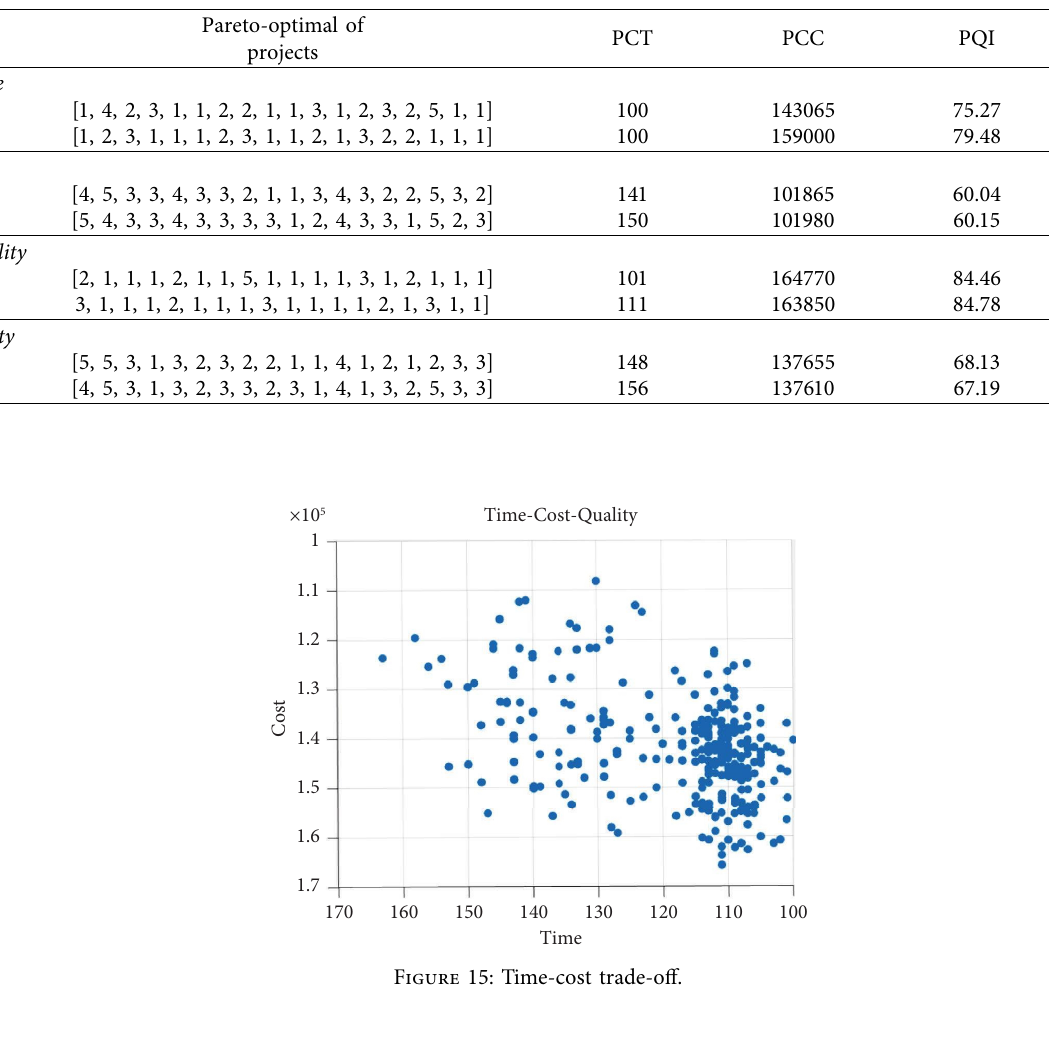
Figure 14: Value path plot of AOSMA for case 1. Table 6: Result Pareto-optimal solutions for case 2.